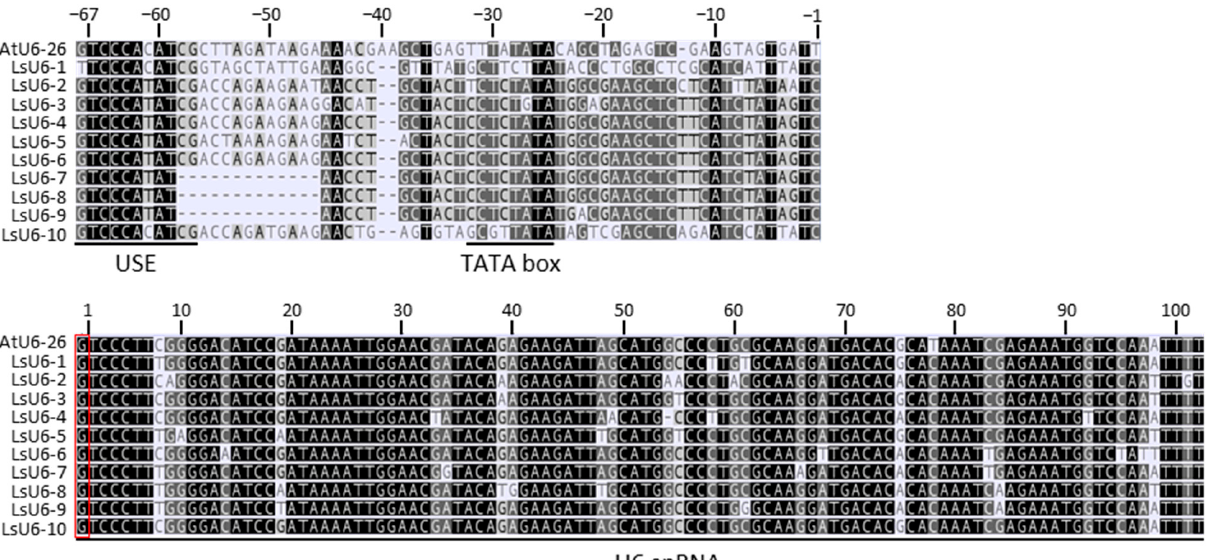
Figure 1. Multiple sequence alignment of lettuce U6 and Arabidopsis U6-26 snRNA genes. Highly conserved portions of the sequence are shown in black. Upstream sequence element (USE), TATA-box and U6 small nuclear RNA (snRNA) sequences are underlined. The transcription start sites (+1) are indicated by a red box. The candidate lettuce U6 genes were named LsU6-1 for LOC111919320, LsU6-2 for LOC111918078, LsU6-3 for LOC111911168, LsU6-4 for LOC111911169, LsU6-5 for LOC111918392, LsU6-6 for LOC111912034, LsU6-7 for LOC111919806, LsU6-8 for LOC111914804, LsU6-9 for LOC111919805, and LsU6-10 for LOC111913621. Note that LsU6-10 showed the highest similarity to AtU6-26.